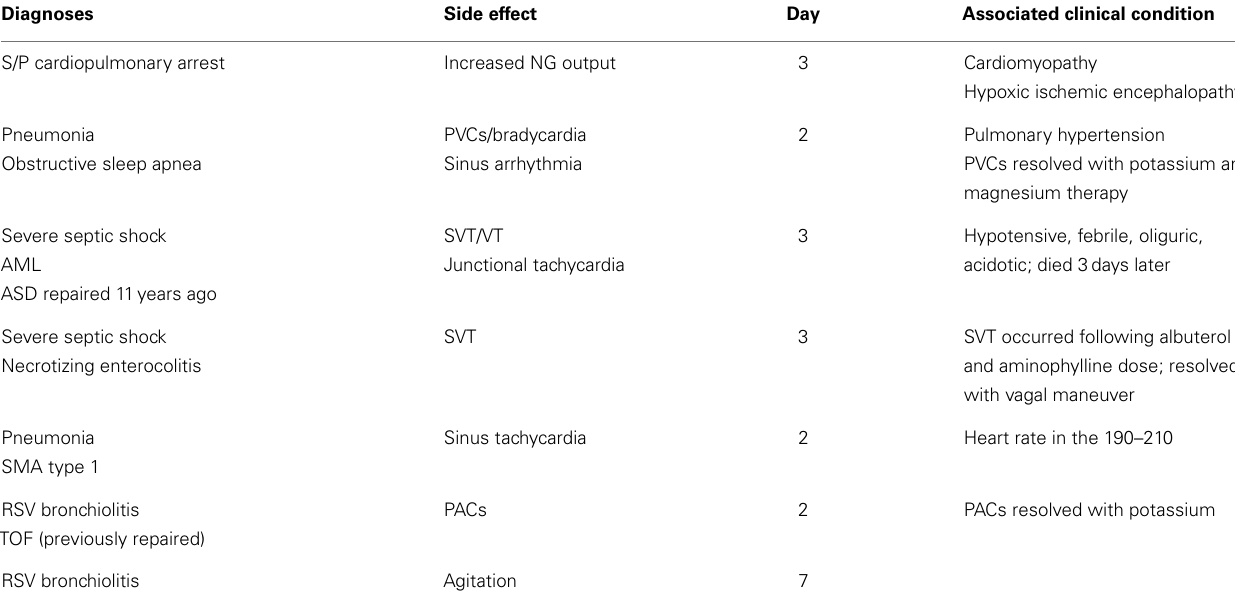
Table 5 | Characteristics of patients with documented side effects